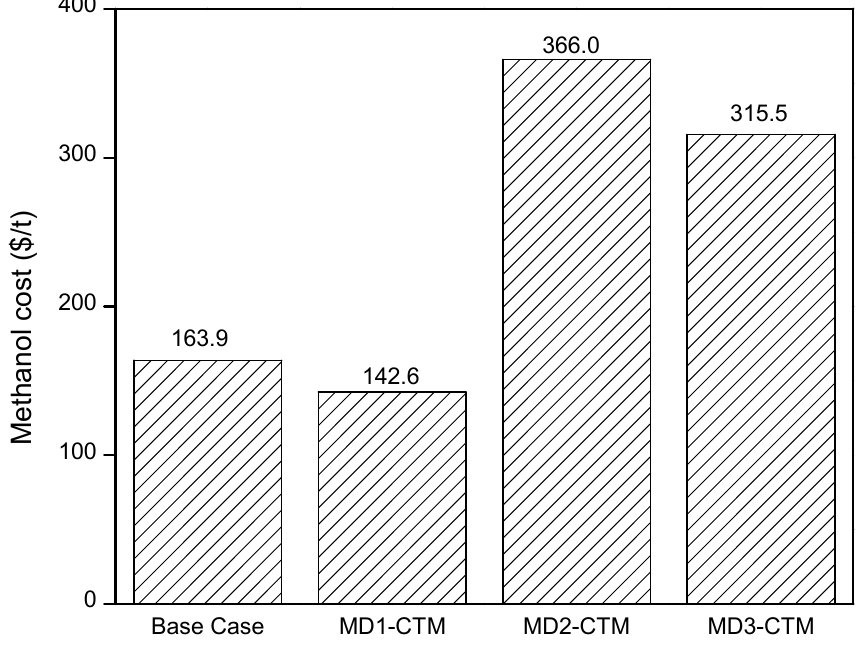
Figure 15. Methanol production cost for the four CTM processes.